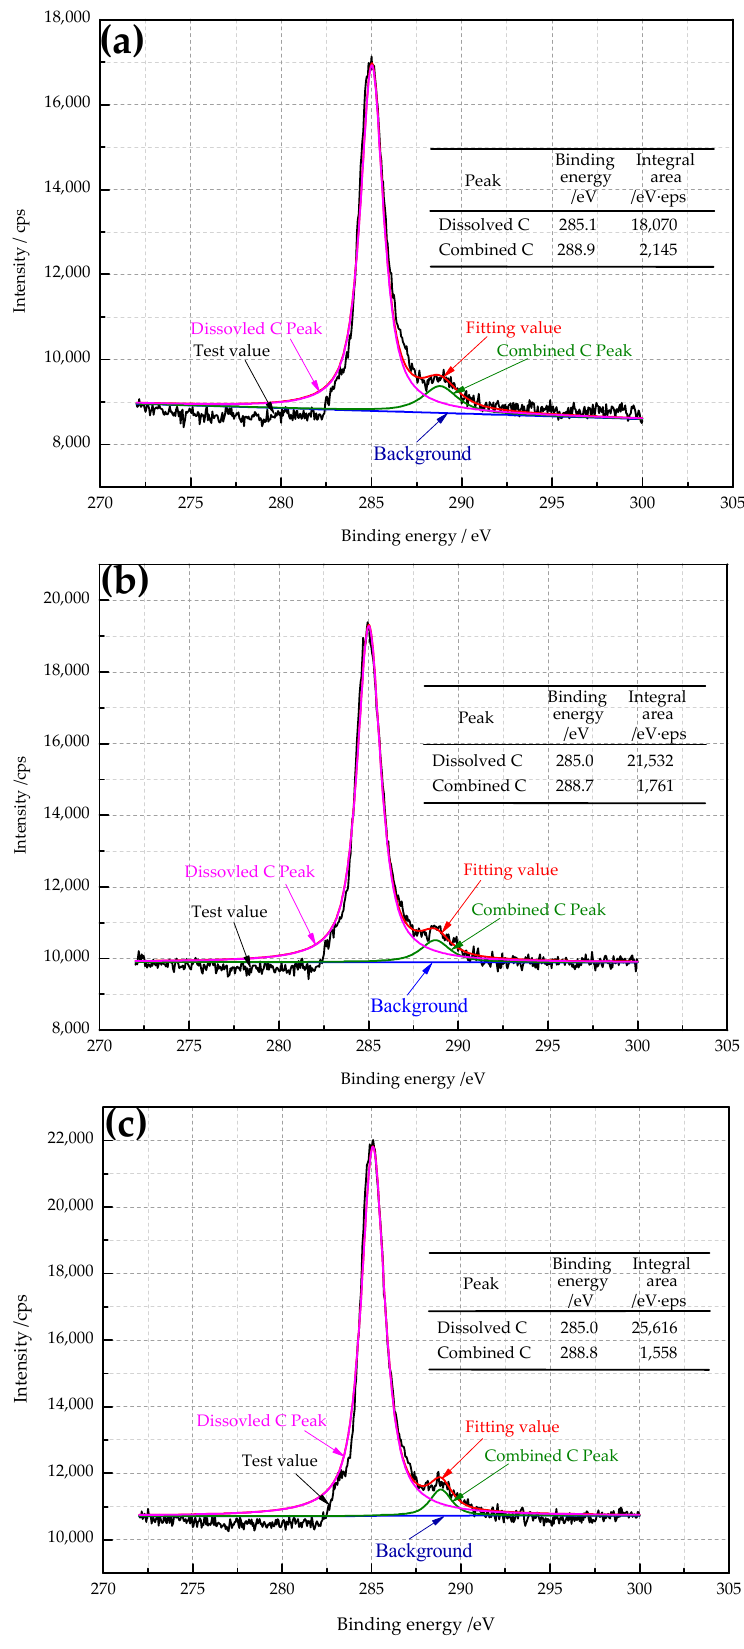
Figure 2. The spectra of carbon 1s by XPS and its fitting curves with different secondary cold reduction rates: ( a ) 15%; ( b ) 20%; ( c ) 25%.